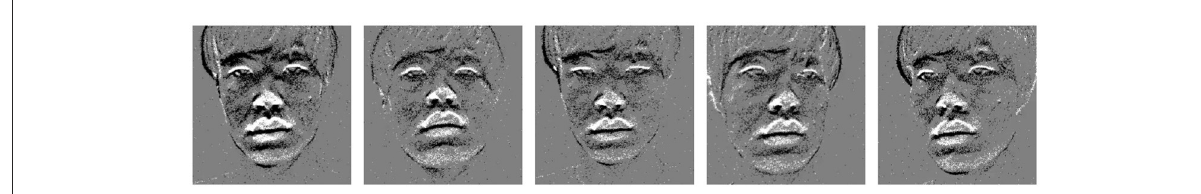
FIGURE6 Face images taken in five directions (front, up, bottom, right, left).